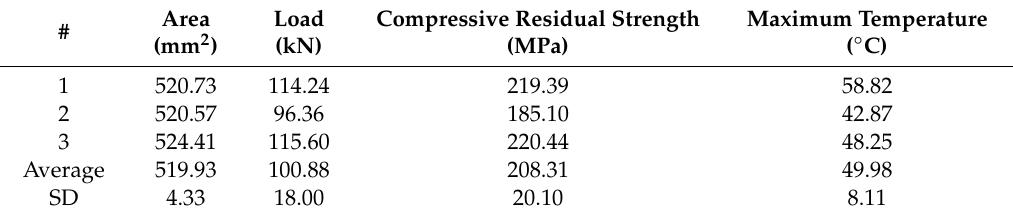
Figure 9. Load and displacement curve of the CAI test, ( a ) Type 1 (24 CFRP), ( b ) Type1-0 (24 CFRP, without impact test), ( c ) Type 2 (20CFRP:2EVA), ( d ) Type 3 (16CFRP:4EVA), ( e ) Type 4 (8CFRP:8EVA, inside), ( f ) Type 5 (8CFRP:8EVA, outside). Table 10. Compression after impact (CAI) test results of Type